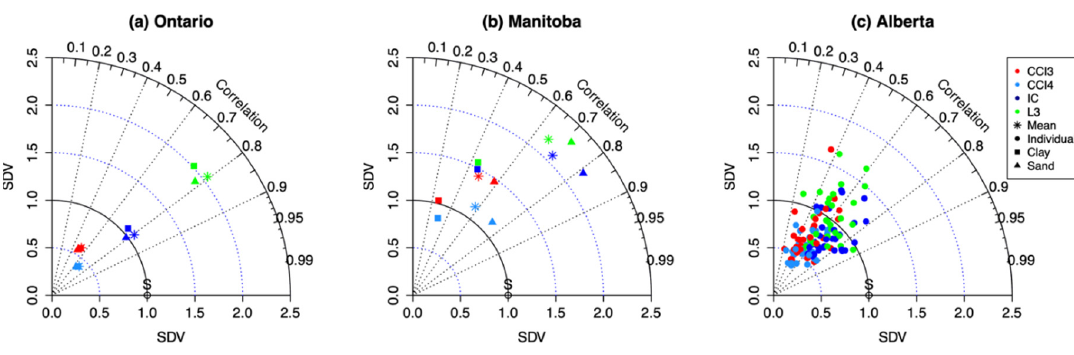
Figure 3. Taylor Diagrams [69] showing a multi-metric statistical comparison between CCI3, CCI4, IC and L3 and in situ soil moisture measurements at 5 cm depth (S) for ( a ) Ontario, ( b ) Manitoba and ( c ) Alberta. These diagrams show the relative position of the satellite soil moisture data to the reference in situ data using temporal linear correlation coefficient and normalized standard deviation. The closer a point is to the in situ measured value, the closer the satellite data is to the ground measured data. The Taylor diagrams for Ontario and Manitoba also include points corresponding to the mean of stations located over different soil types, that is, sand and clay.